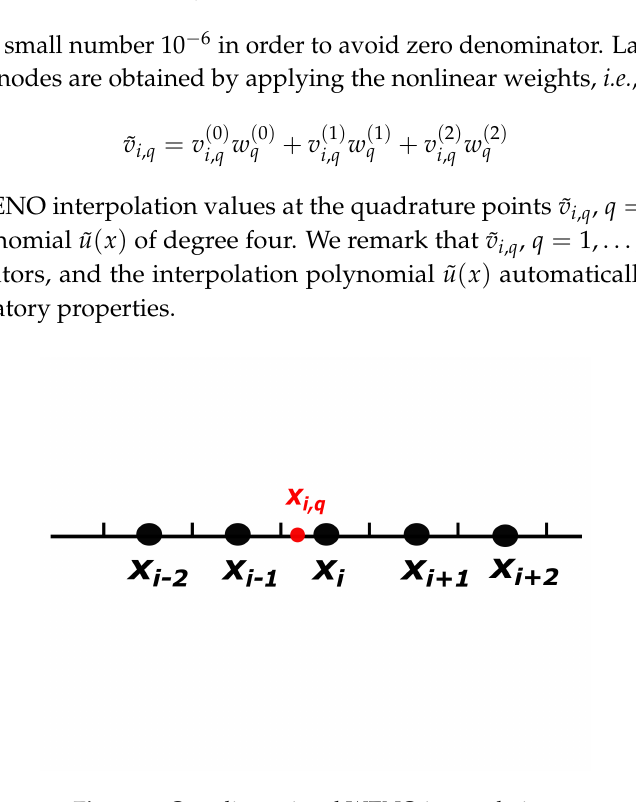
Figure 1. One-dimensional WENO